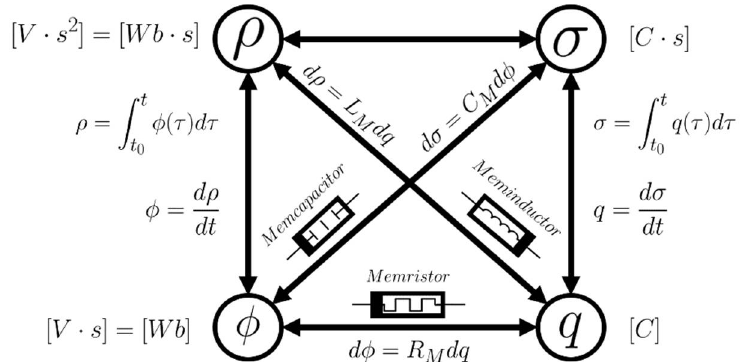
Figure 1. Mem-elements definition on the basis of their fundamental physical magnitudes (units are presented in brackets). Memristor: relation between the charge ( q ) and the time-integral of the voltage ( ϕ ); memcapacitor: relation between time-integral of the charge ( σ ) and the time-integral of the voltage ( ϕ ); meminductor: relation between time-integral of the flux ( ρ ) and the charge ( q ) [35].